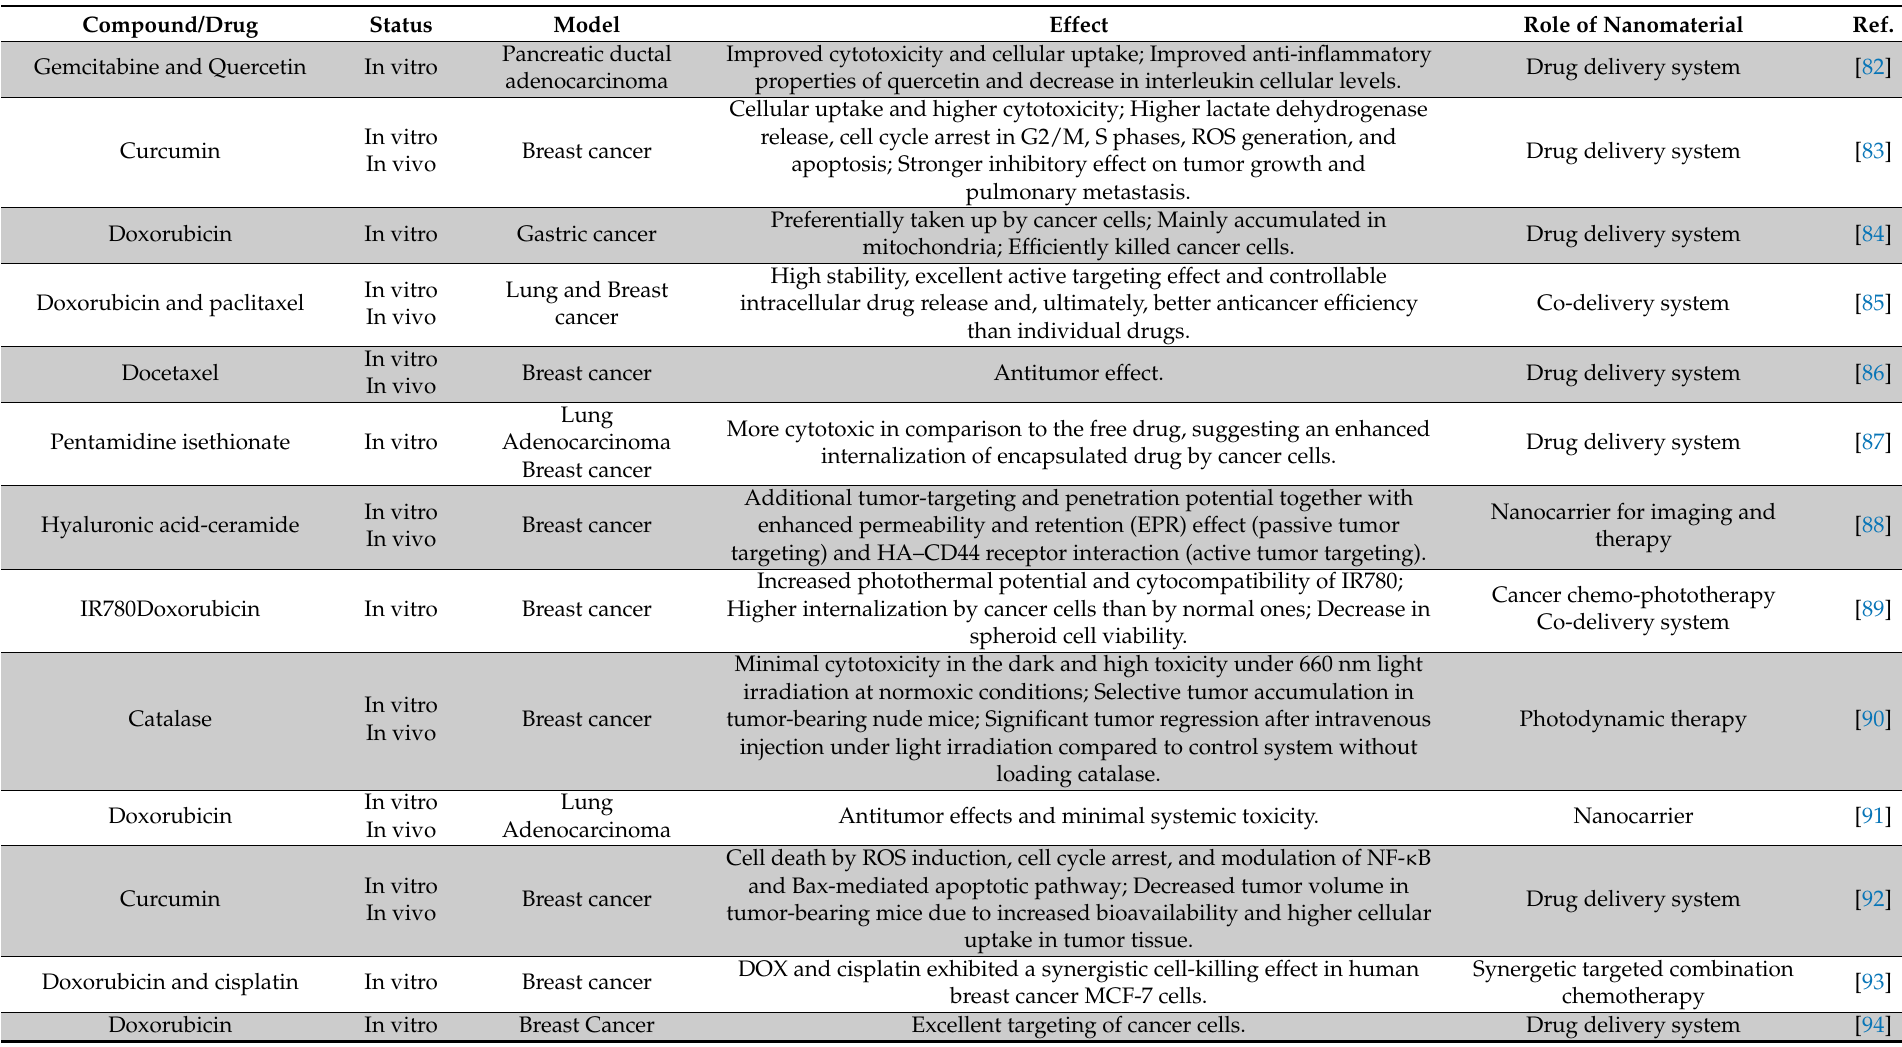
Table 4. Recent application of HA-based nanoparticles in cancer